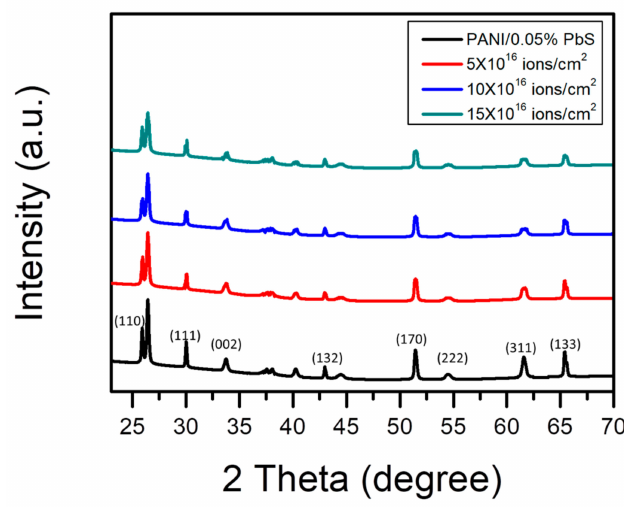
Figure 2. XRD of pure and treated PANI/PbS.